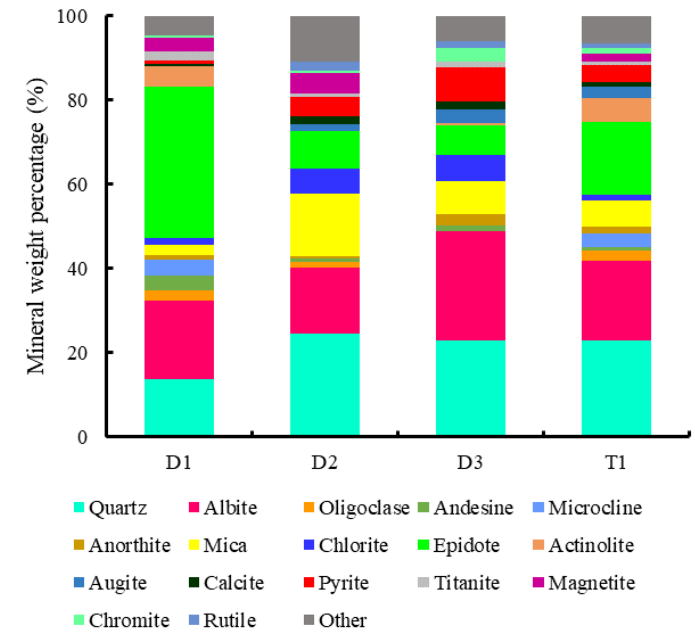
Figure 4. Mineralogical composition of composite samples.